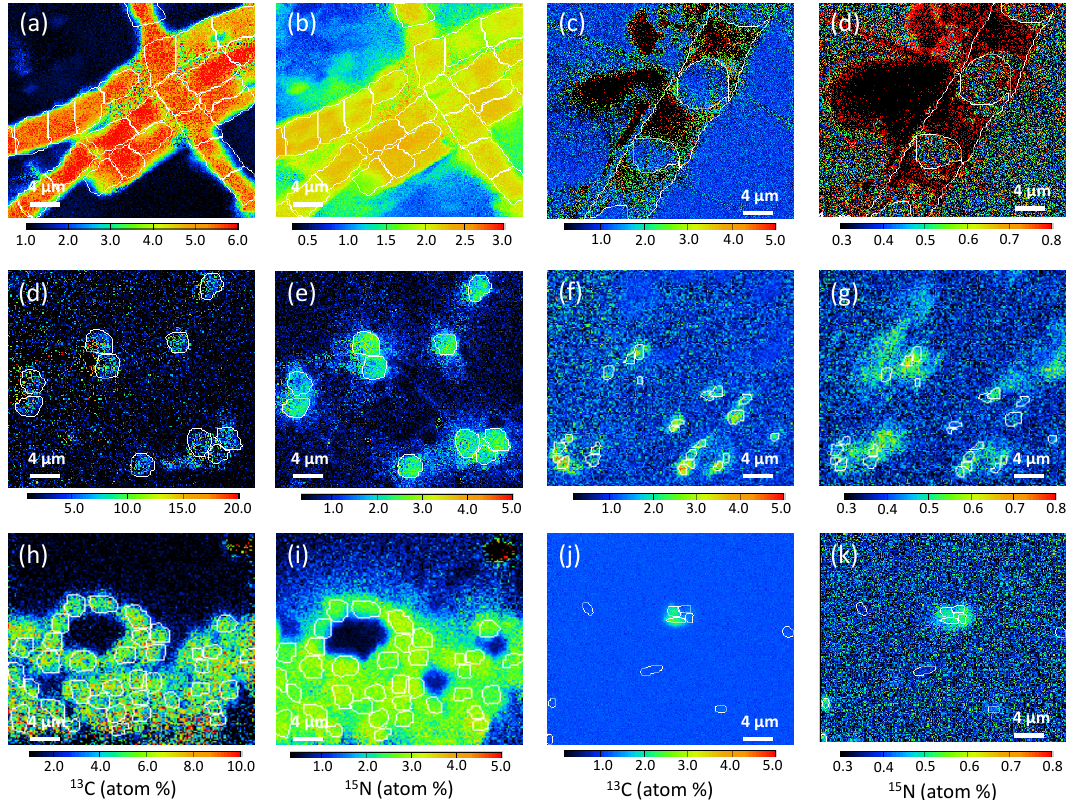
Figure 4. NanoSIMS images showing the isotopic enrichment found in cells after 48h of incubation. 13 C- (a, d, h, c, f, j) and 15 N- (b, e, i, d, g, k) enrichments (atom%) are shown for T. erythraeum (a, b) , C. watsonii (d, e) , Cyanothece (h, i) , Chaetoceros sp. (c, d) , Synechococcus (f, g) and bacteria cells (j, k) . The white outlines define the regions of interest (ROIs), which were used to estimate the cells 13 C- and 15 N-